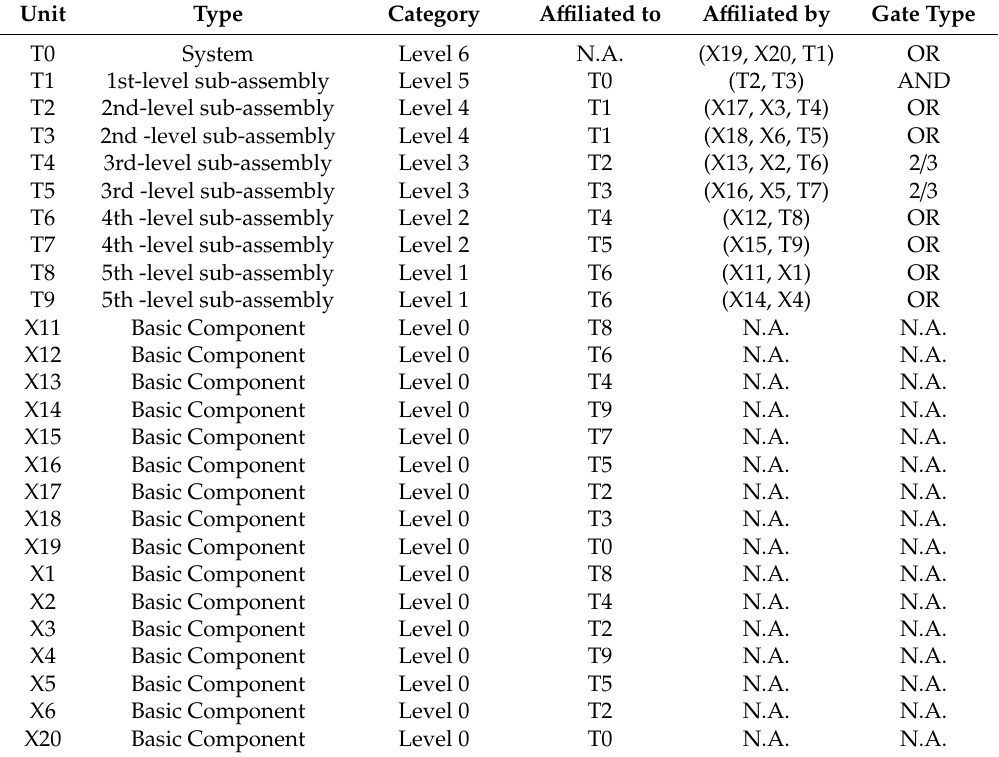
Table 5. Hierarchy of energy transfer